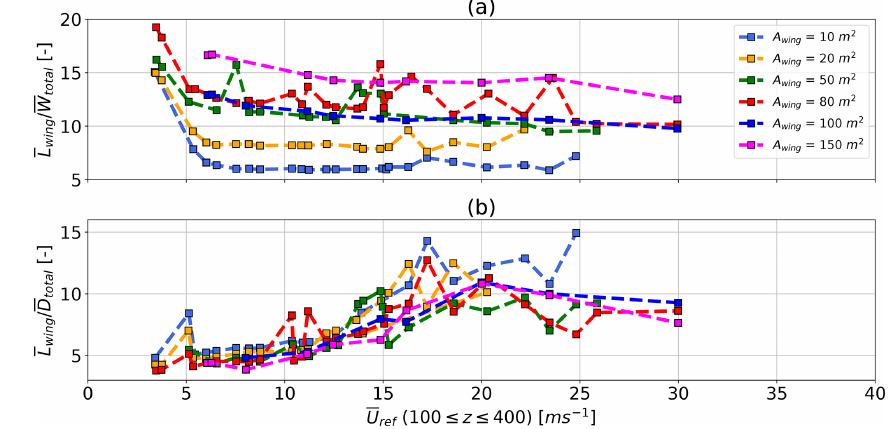
Figure 15. Ratio of cycle average total weight W total to lift L wing (a) and cycle average total drag D total , including tether drag, to lift L wing (b) during production phase (reel-out) for all aircraft sizes A = 10–150m 2 for AP2 reference aerodynamic coefficients and a mass-scaling exponent of κ = 2 . 7 over reference wind speed